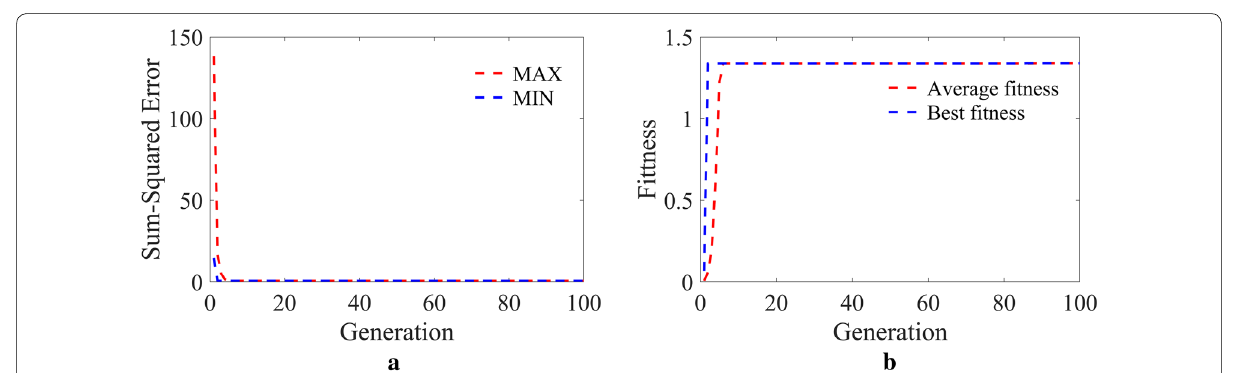
Fig. 8 Genetic algorithm optimization results: a reciprocal of sum-squared errors; b fitness